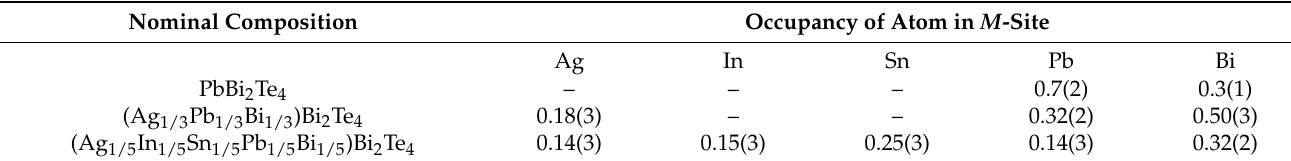
Table 1. Occupancies of atoms in the M site. The numbers in the brackets are standard deviations. Nominal Composition